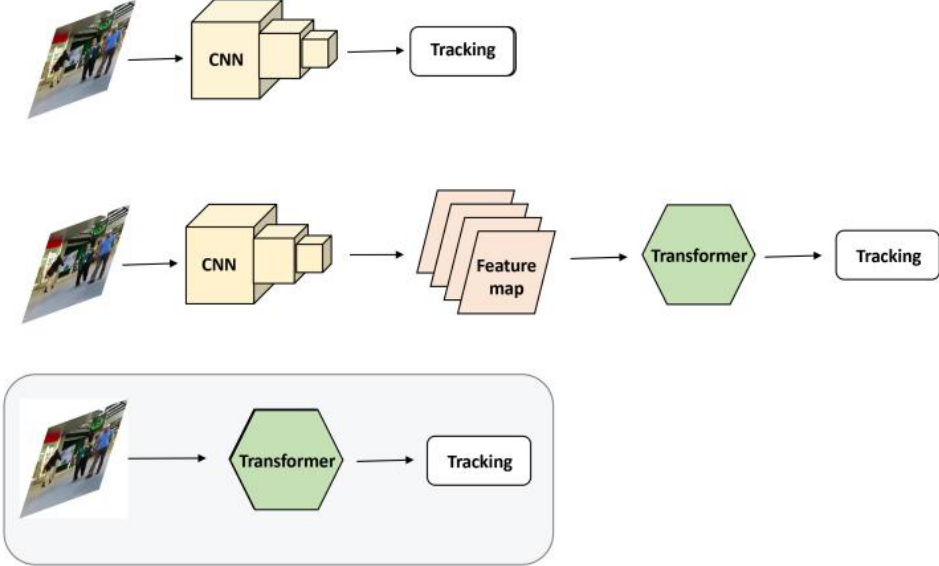
Figure 1. Comparison of different model architectures. Top diagram: In the traditional MOT model, a CNN is the foundation and is essential. Middle diagram: Although some works introduce a transformer into the computer vision models, they still need a CNN to extract the feature map first. Bottom diagram: Our work aims to explore the MOT model based on the transformer backbone. The identifiable image in this figure is from the public dataset MOT16.